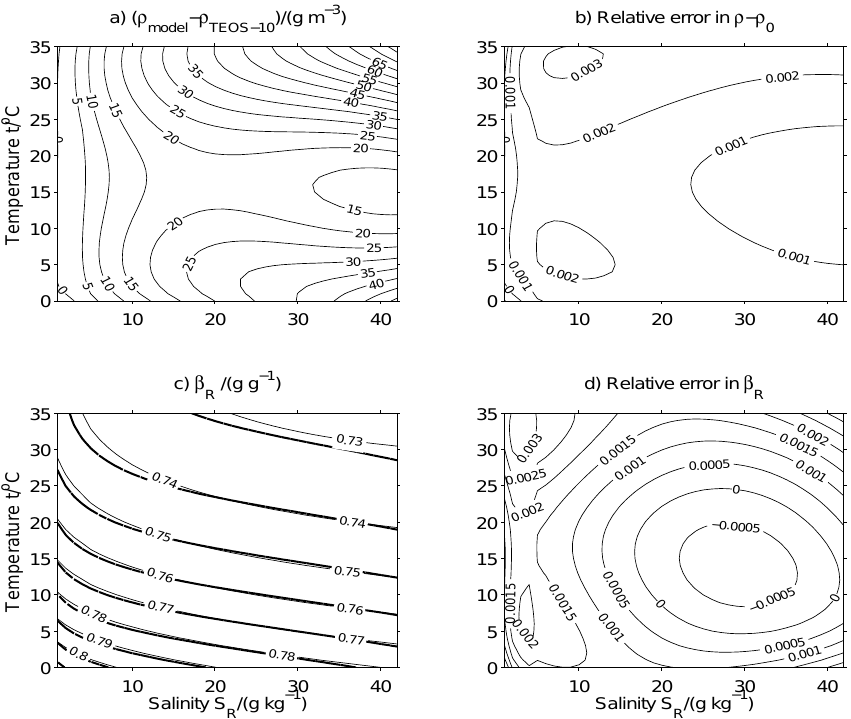
Fig. 2. Comparison between TEOS-10 and LIMBETA densities and haline contraction coefficient, over the general range of seawater. (a) Differences in predicted densities. (b) Relative error in density anomaly from pure water values. (c) β R for model (thick dashed lines) and from TEOS-10 (thin lines). (d) Relative error in model β R